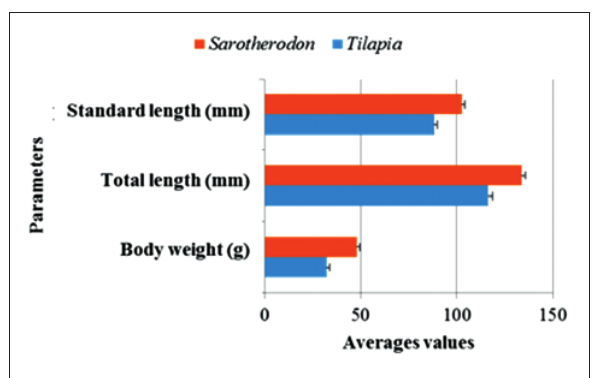
Figure-2: Morphometric parameters of Tilapia guineensis and Sarotherodon melanotheron in Ahémé Lake